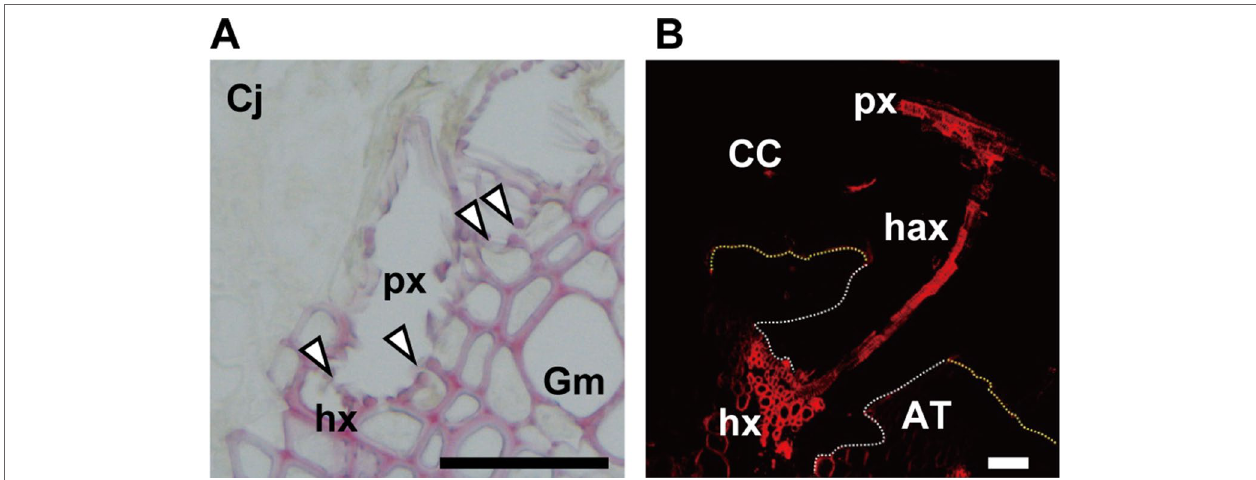
FIGURe 4 | (A) Open connection (arrowheads) between xylem vessels of parasite (px) and host (hx) in the parasitic interface of Cuscuta japonica (Cj) with Glycine max (Gm). Scale bar, 50 μm. A 20-μm-thick paraffin-embedded section was stained with phloroglucinol. (B) Transfer of 5-carboxytetramethylrhodamine (TMR) 10-kDa dextran (red) from host xylem vessel to haustorial xylem vessels, and then to Cuscuta stem xylem. White dotted line; outline of haustorium, yellow dotted line; outline of attachment boundary between Cuscuta and host Arabidopsis . CC, Cuscuta campestris ; AT, Arabidopsis thaliana ; px, parasite xylem vessel; hax, haustorial xylem vessel; hx, host xylem vessel. Scale bar, 200 μm.